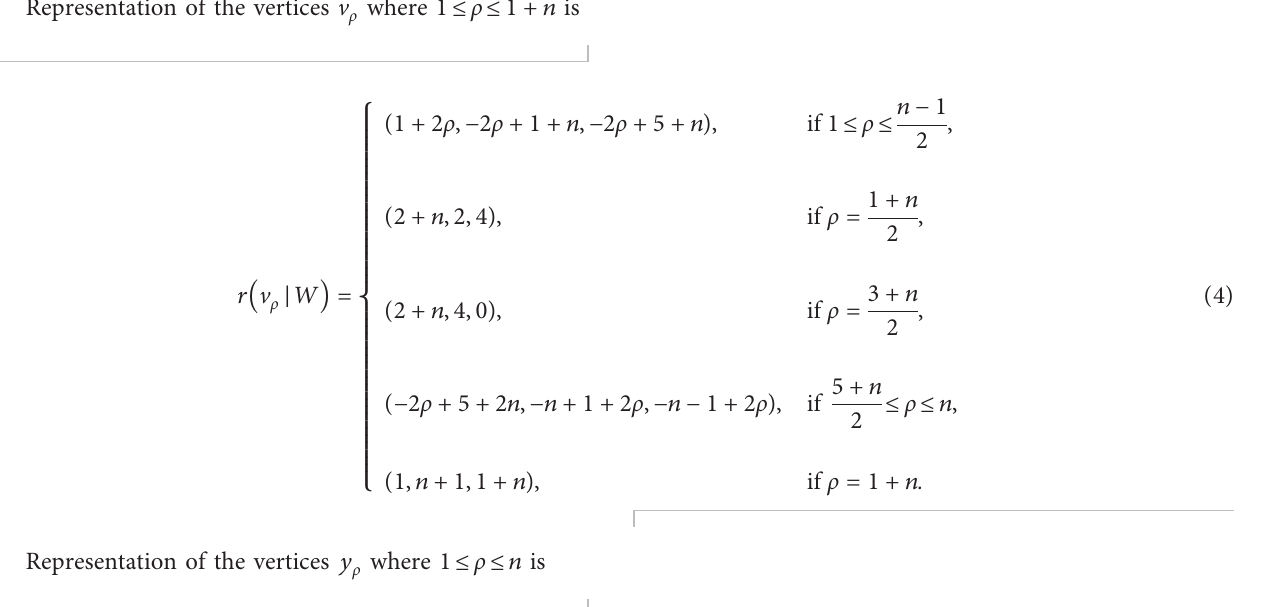
Figure 3: Necklace graph N